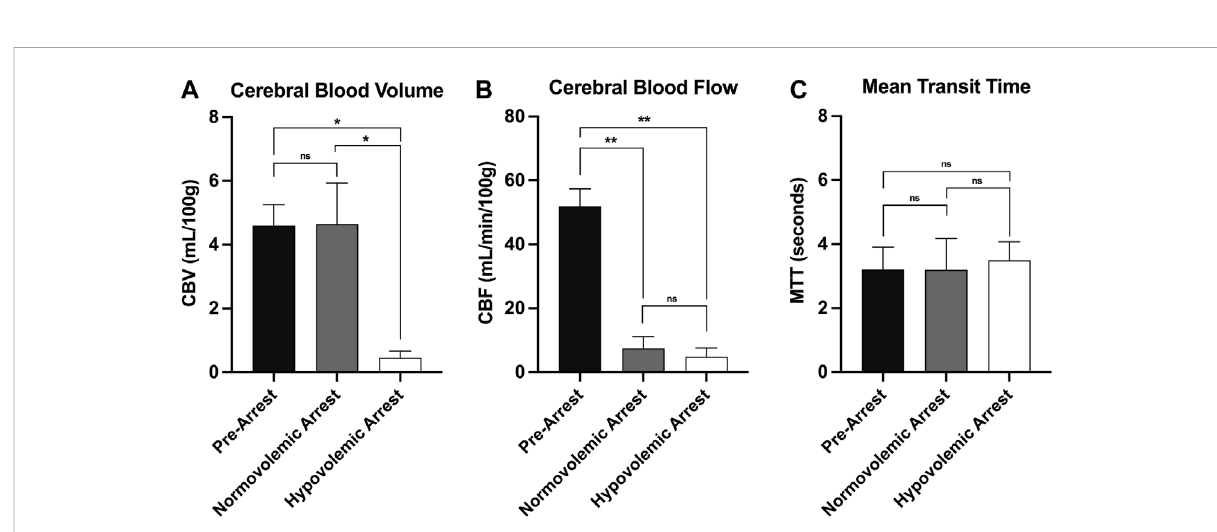
FIGURE 6 | CT perfusion metrics of cerebral perfusion with comparison of (A) cerebral blood volume, (B) cerebral blood fl ow, and (C) mean transit time duringnormovolemicpre-arrest,normovolemicarrest,andhypovolemicarrestwithstatisticalsigni fi cancedenotedongraph.Statisticalsigni fi cance of p < 0.05 is denoted as *, p < 0.001 is denoted as **, and non-signi fi cant p-values are denoted as